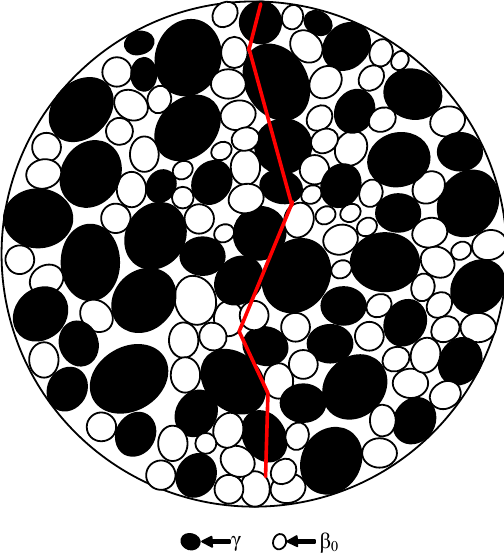
Figure 10. The crack propagation model in the fine γ+β 0 microstructure.